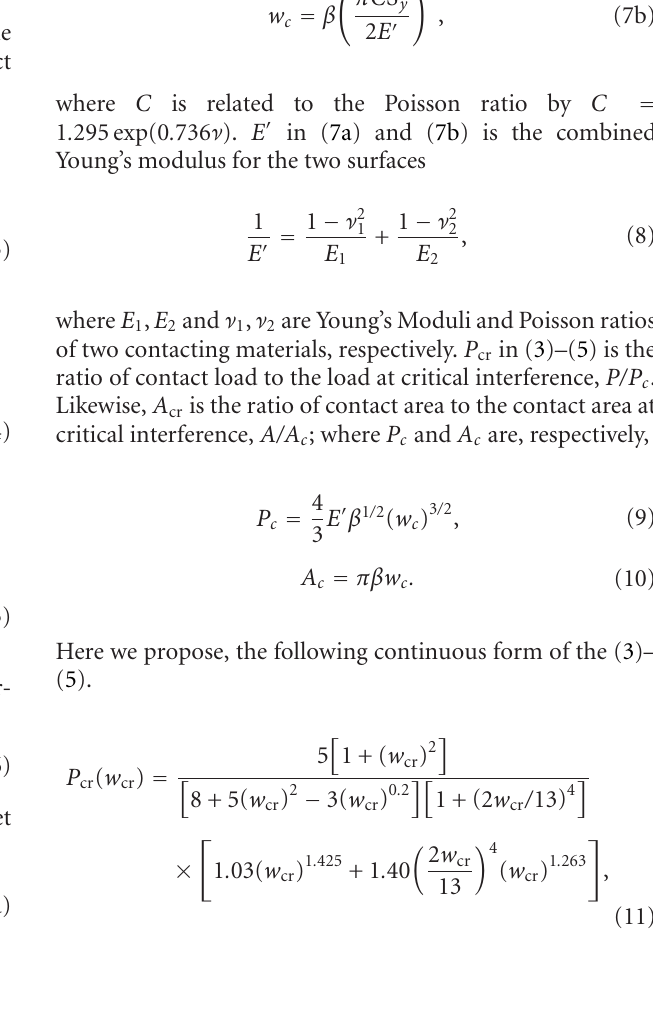
where β s is the sum of curvature radii of asperity summits and r the tangential o ff set of the mating asperities so that when r = 0 the asperities interfere along the normal to the mean planes. In (1) and (2) the parameters have been normalized with respect to the standard deviation of asperity height sum σ , so that s is ( z 1 + z 2 ) /σ , h is d/σ and r and σ as the normalization β s are the normalized values using